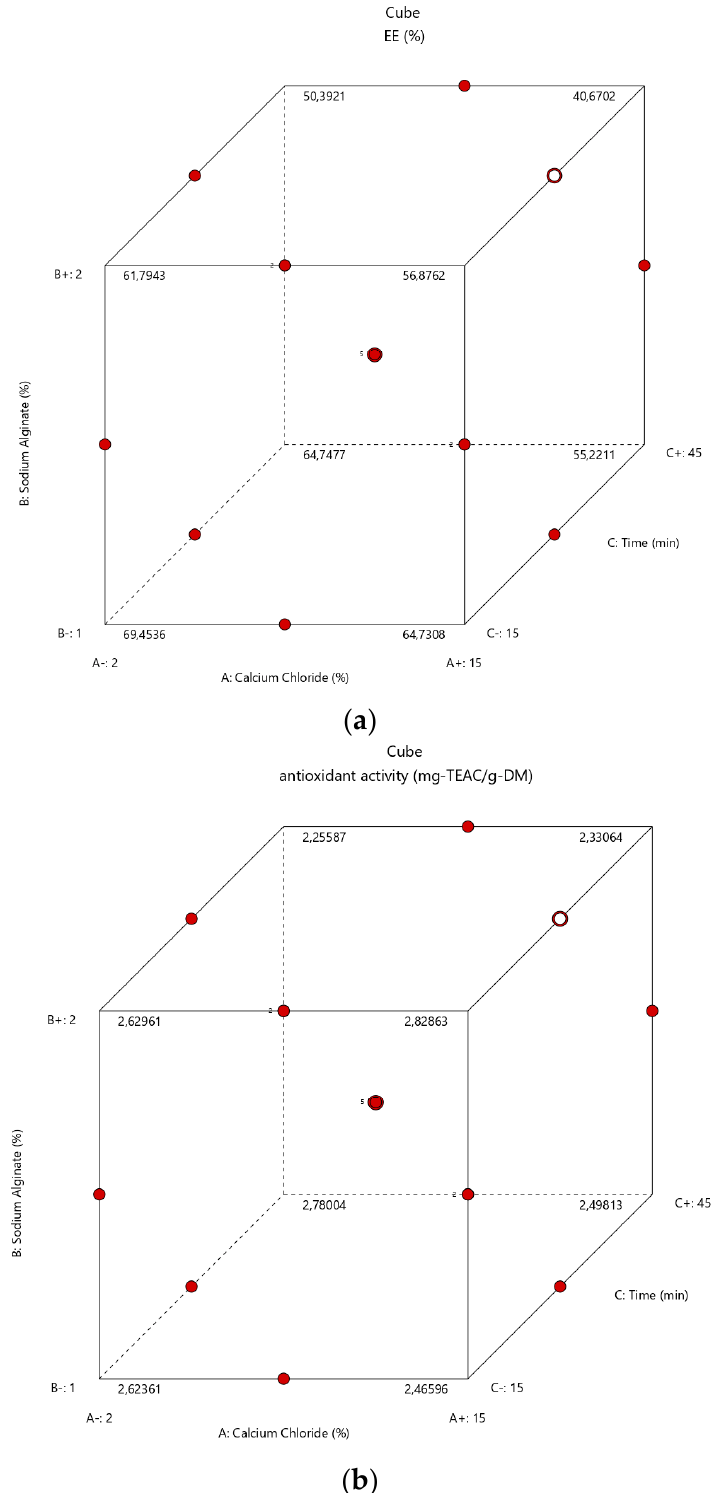
Figure 4. Illustration of Box–Behnken design for the three factors and three levels of the ionic gelation process for response EE ( a ) and reponse antioxidant activity ( b .